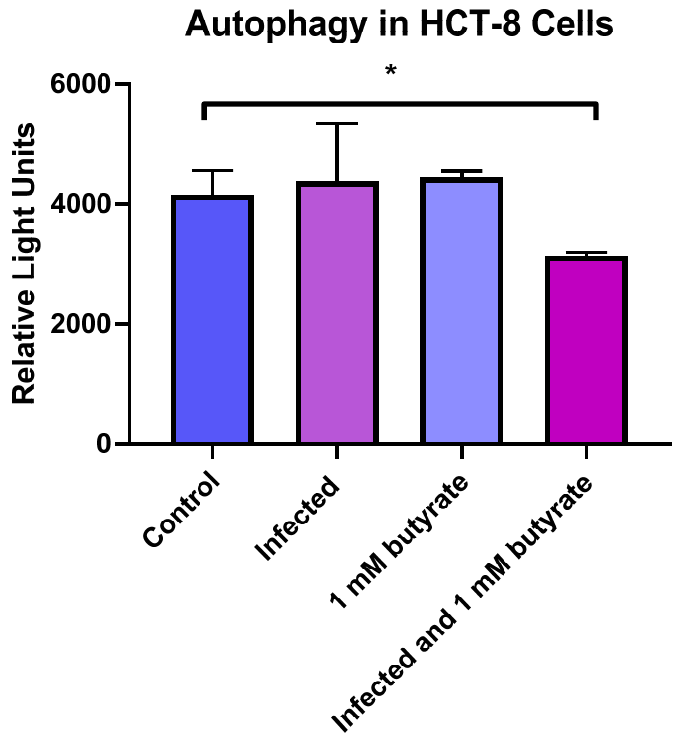
Figure 3. Amount of autophagy in C. parvum -infected and butyrate-treated cells. HCT-8 cells were infected with C. parvum and/or treated with 1 mM of butyrate for 24 h, after which the cells were analyzed for percent autophagy. Control wells (uninfected, untreated) were compared to treated control wells. Values are means ± SEM, n = 4. * Different from control, p < 0.05.